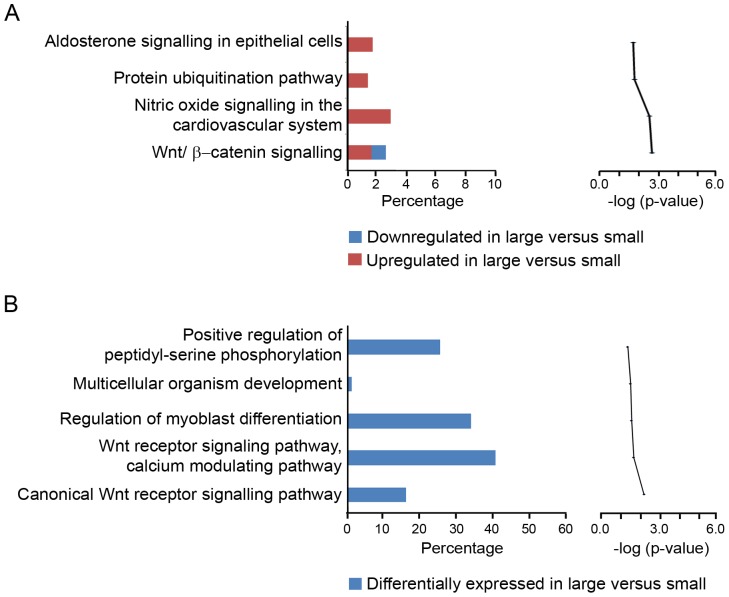
Top canonical pathways mapped in IPA (A) and GO terms (B) classified under biological process.In (A) the bar chart on the left represents the percentage of genes from the data set that map to each canonical pathway showing those which are up regulated (in red) and down regulated (in blue) in theca of large with respect to small healthy follicles. The line chart on the right ranks these pathways derived for the same data set, from the highest to lowest degree of association based on the value of a right-tailed Fisher's exact t test. In (B) the bar chart on the left represents the percentage of genes from the data set that map to each GO term showing those which are differentially regulated (in blue) in theca of large with respect to small healthy follicles. The line chart on the right ranks these pathways derived for the same data set, from the highest to lowest degree of association using the Benjamini-Yuketeli test for multiple corrections (bottom to top in graphs on right).